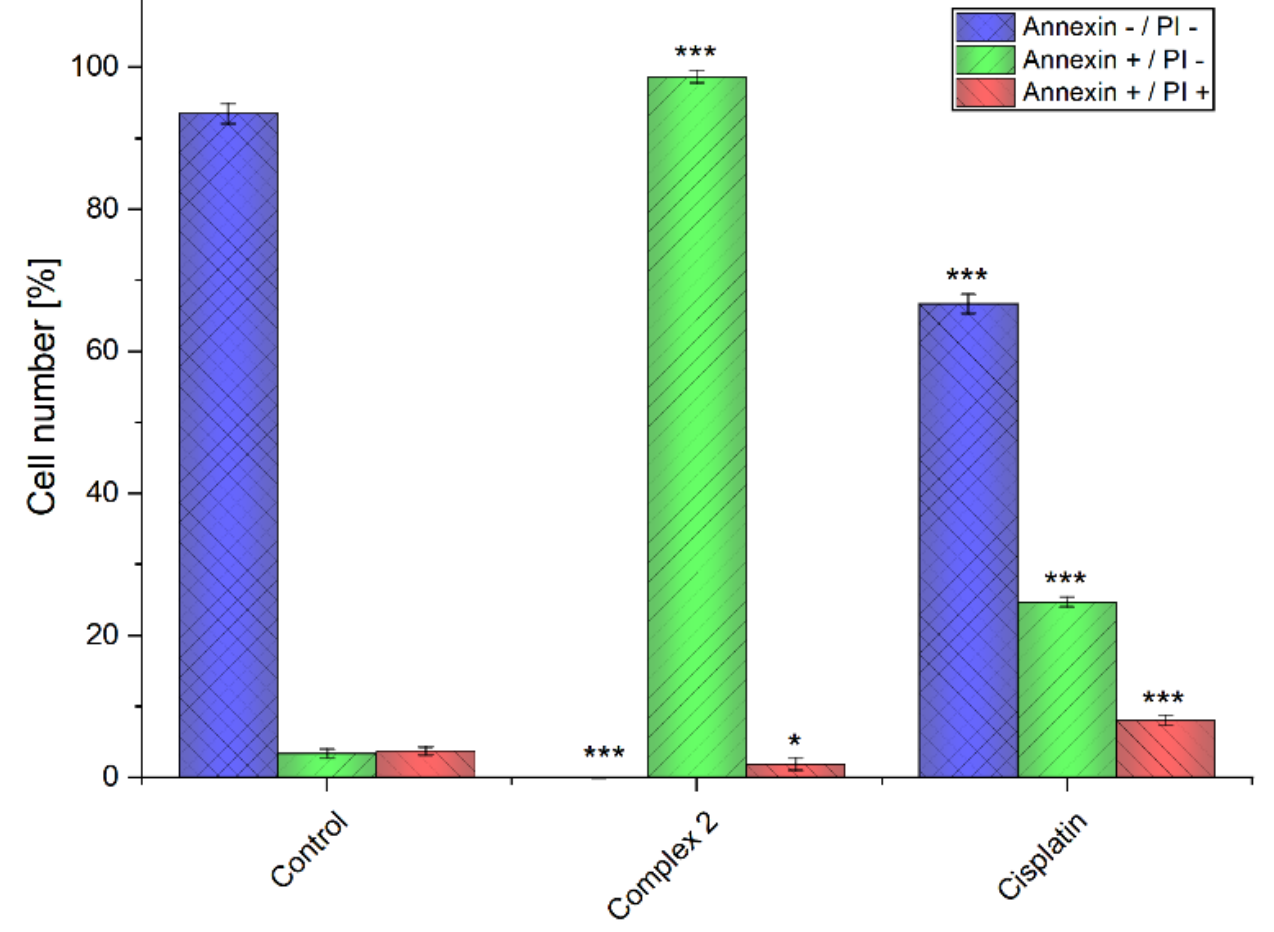
Figure 6. The effects of complex 2 (3 μM) and cisplatin (19 μM) on cell death induction in the A2780 cells after 24 h of incubation. The significant change in the number of cells in different stages of cell life/death caused by the respective complex compared to the untreated control is symbolized by * p ≤ 0.05, and *** p ≤ 0.005 level.